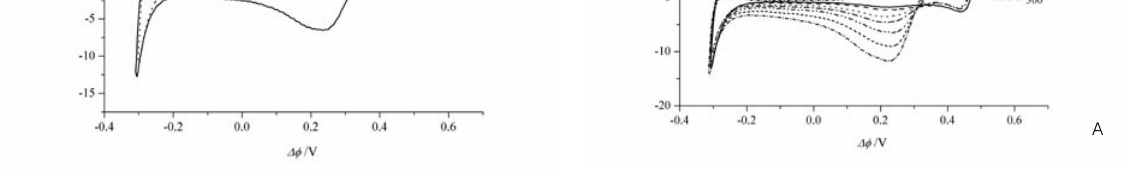
Figure 2. The voltammograms of the background (dashed) and the assisted 150 μM Cd 2+ ion transfer (line) across the water/1,2-DCE interface in Cell 1(x=10 mM and v =50 mV s -1 )